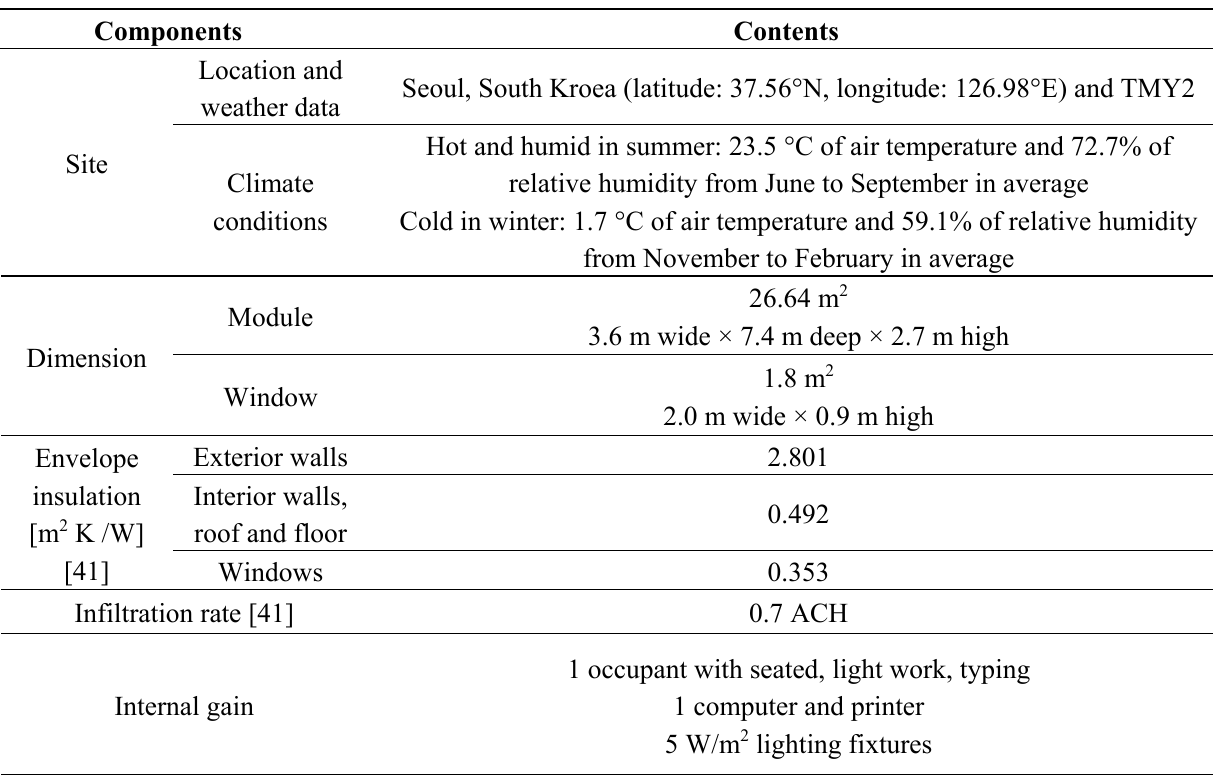
Figure 4. Composition of the simulation model. Table 2. Features of the test